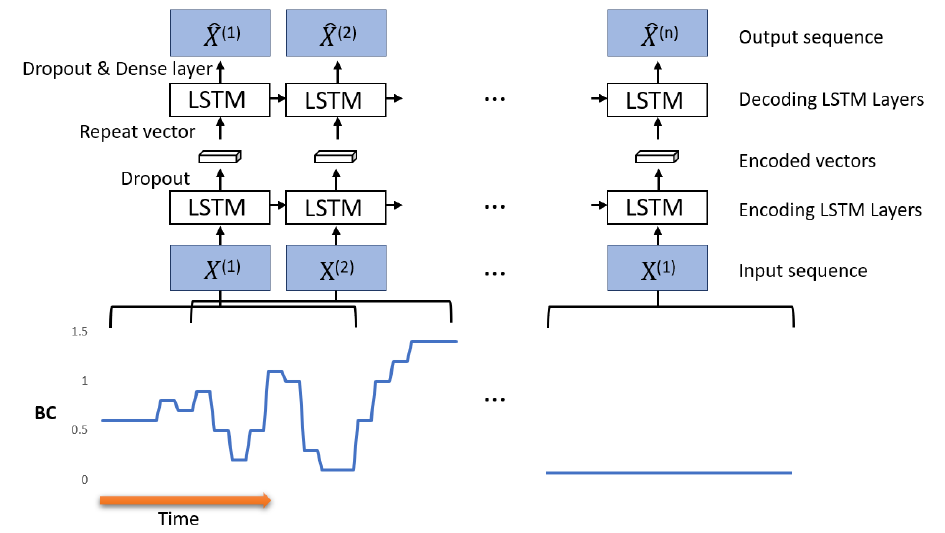
Figure 2. Architecture of our proposed model for detecting anomaly from the BOU